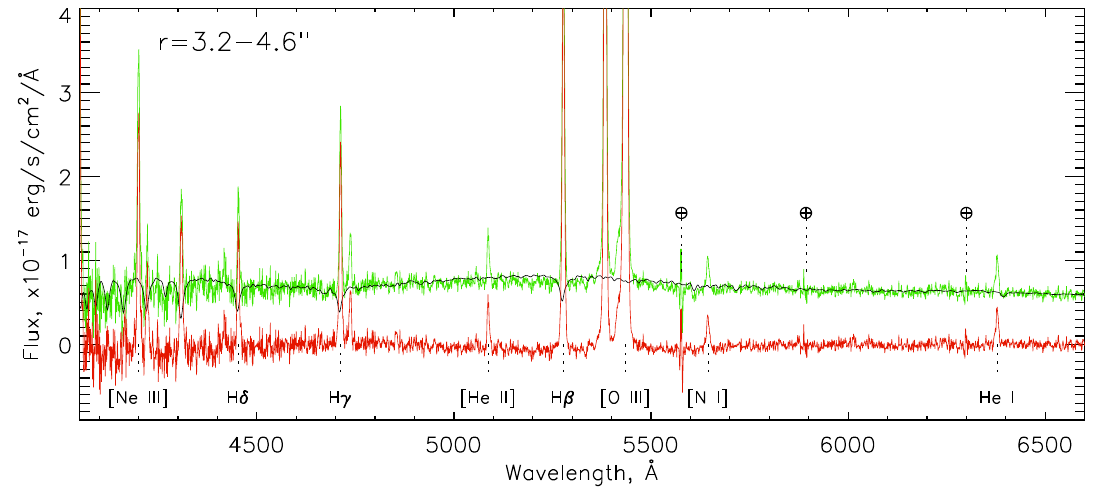
Figure 2. pPXF analysis of the observed spectrum (the green line) in the radial bin corresponds to the distance from the Teacup nucleus r = 3.2–4.6 (cid:48)(cid:48) . The stellar population model is shown in black, the red spectrum is a residual after model subtraction. The main ionized gas emission lines and position of the airglow lines are labeled.